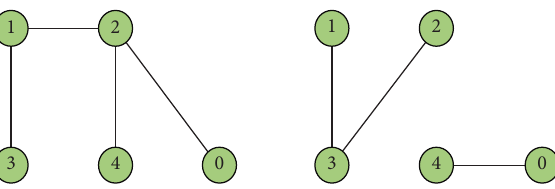
Figure 2: Communication topology G